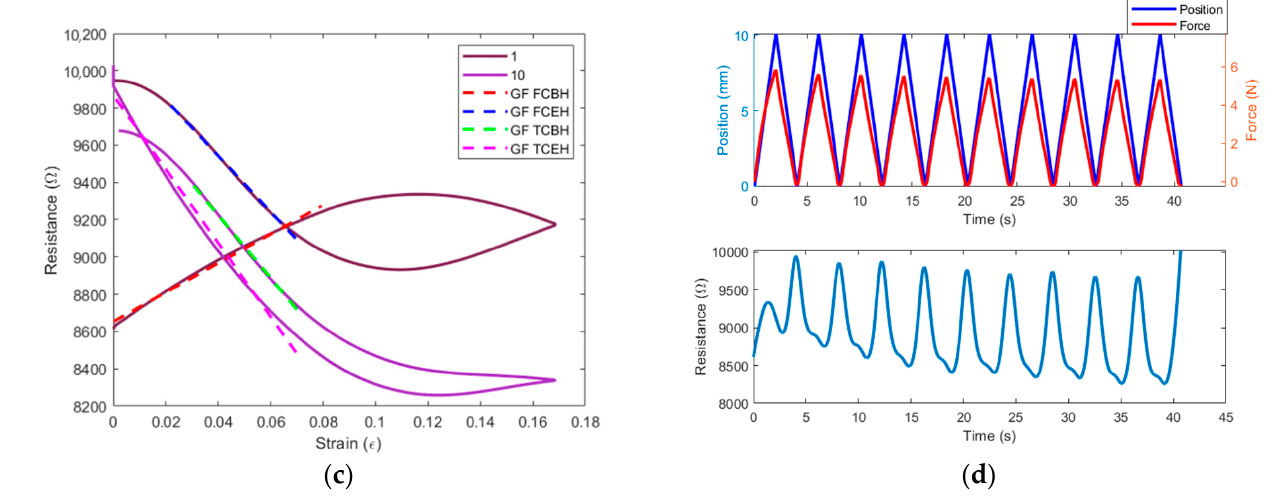
Figure 12. CRE cyclic tensile test results: ( a ) Resistance vs. strain for ten cycles. ( b ) Stress vs. strain for ten cycles. ( c ) Resistance vs. strain and gauge factors for the first and the tenth cycles. ( d ) Displacement, force, and resistance change over time for ten cycles.